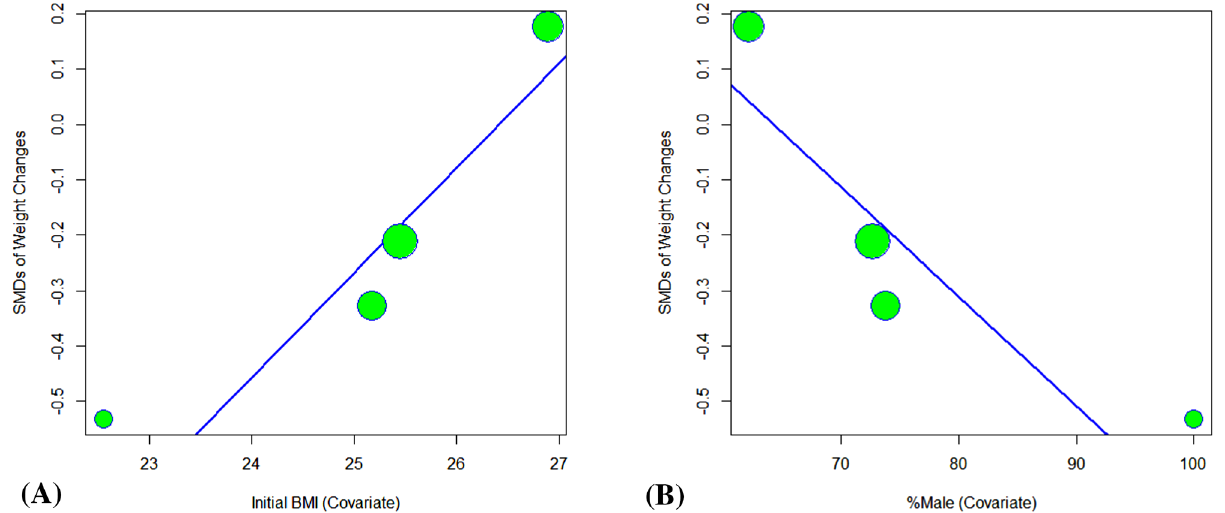
Figure 5. Bubble plots with fitted meta-regression lines of the SMDs of weight changes and the initial BMI (β = 0.19; p = 0.002) ( A ) or percentage of male participants (β = − 0.02; p = 0.012) ( B ). Circles are sized according to the inverses of the effect-size